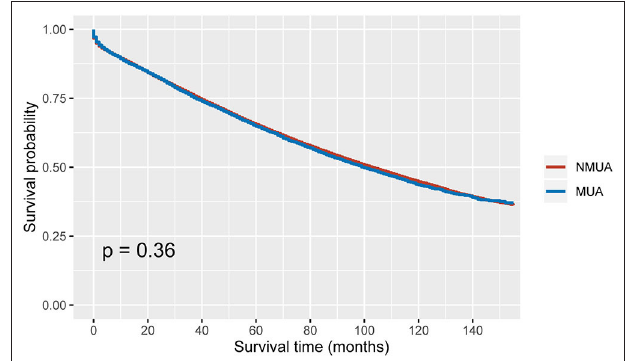
FIGURE 2 | Kaplan–Meier curves for overall survival in stage II colon cancer.